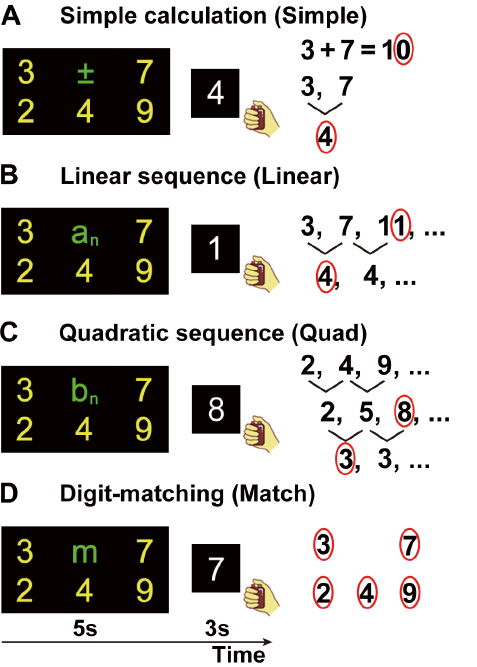
Figure 1. Examples of the stimuli used in the arithmetic task and Match task. Five yellow digits, together with a green character as a cue, were presented for 5 s, followed by the presentation of one white digit (matching stimulus) for 3 s. For each example, the task- relevant digits and a brief outline of the calculation processes are shown in the right panels, where the digits circled in red are the digits stored in memory for digit-matching. The participants judged whether one of those stored digits appeared as a white digit; all white digits shown here are correct examples. (A) Under the Simple condition, indicated by the presentation of ‘‘ 6 ’’ as a cue, the addition and subtraction of the upper two digits (i.e., two of the five yellow digits) were mentally performed by the participants. We instructed the participants to always subtract a smaller value from a larger value. (B) Under the Linear condition, indicated by the presentation of ‘‘a n ’’ as a cue, the third term of a linear sequence initiated by the upper two digits was calculated by the participants. The first row at the top of the right panel represents the linear sequence, and the second row with branches represents the constant differences between each pair of adjacent terms in the linear sequence, as often used in math textbooks. (C) Under the Quad condition, indicated by the presentation of ‘‘b n ’’ as a cue, the following arithmetic calculations were performed by using the lower three digits (i.e., three of the five yellow digits). The first row in the right panel represents the given quadratic sequence. The second row represents the differences between each pair of adjacent terms in the given sequence. The participants were asked to regard the resultant second row as a linear sequence, whose third term was then calculated in the same manner as the Linear condition. (D) In the Match task, indicated by the presentation of ‘‘m’’ as a cue, the participants stored all of the five digits in memory. doi:10.1371/journal.pone.0111439.g001 the arithmetic task and the Match task, respectively (the digits circled in red in Figure 1 and 2).